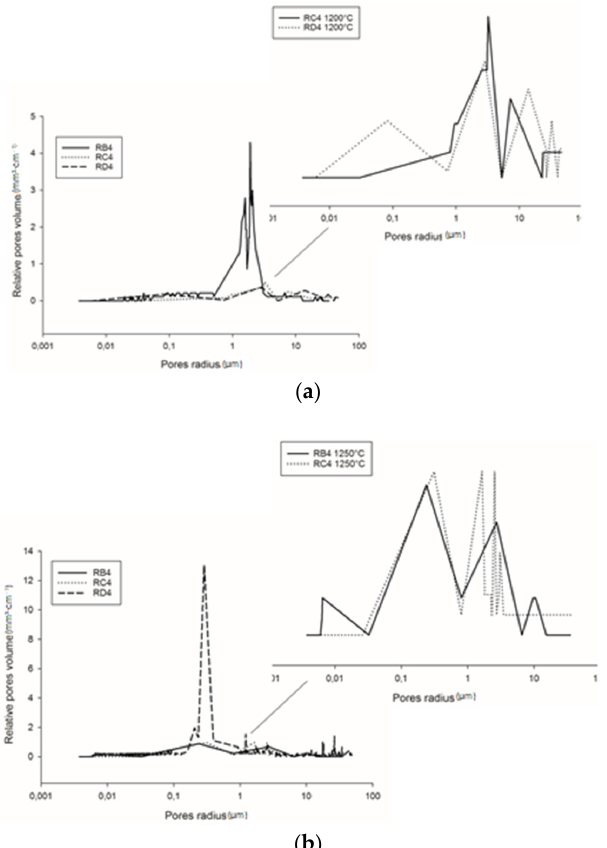
Figure 10. Pore size distribution of the cold-setting refractory composites: ( a ) at 1200 °C and ( b ) at 1250 °C.